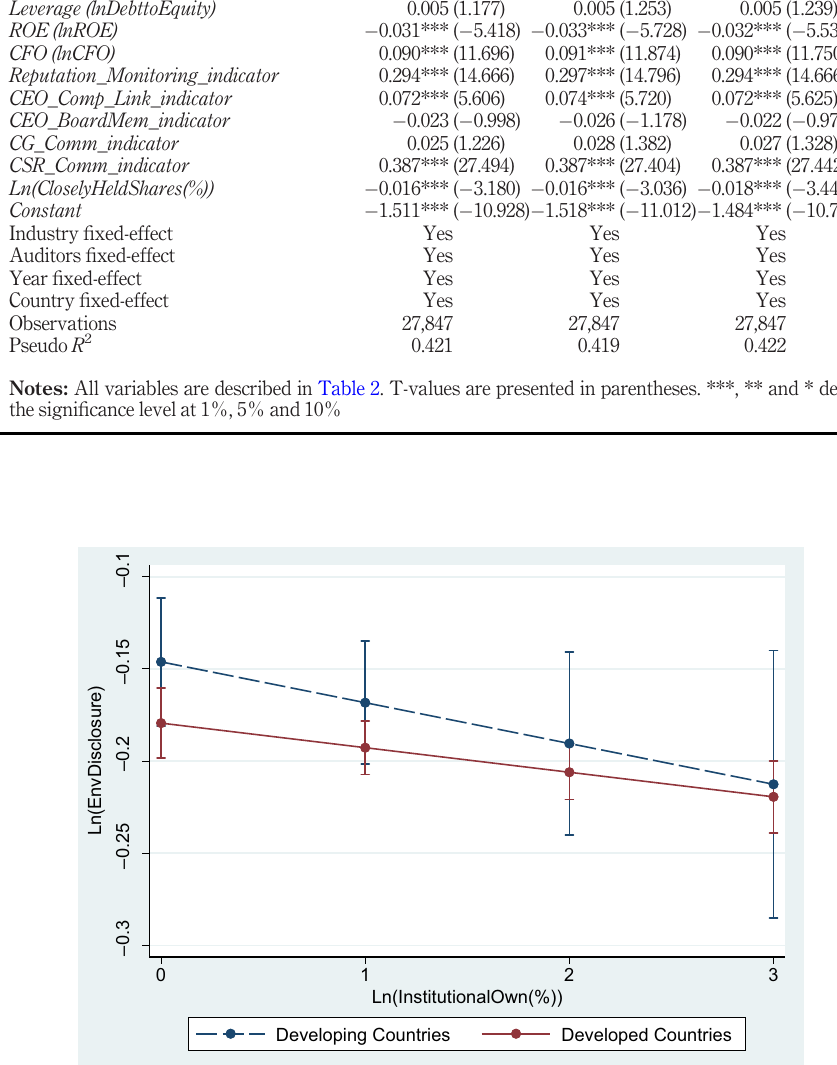
Figure 2. Interaction of Ln